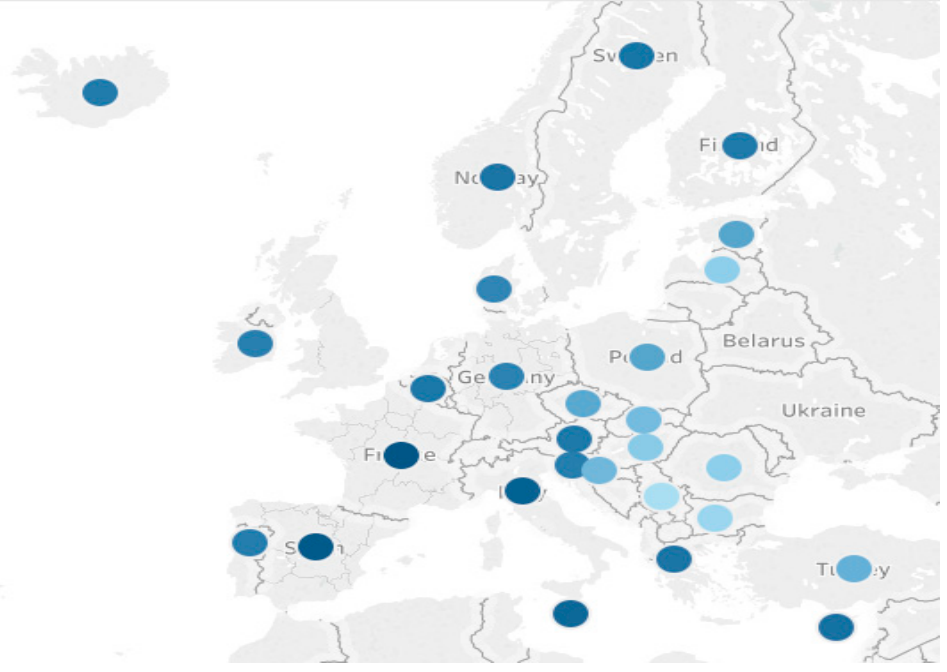
Figure 4. Clustering regarding life expectancy and healthy life